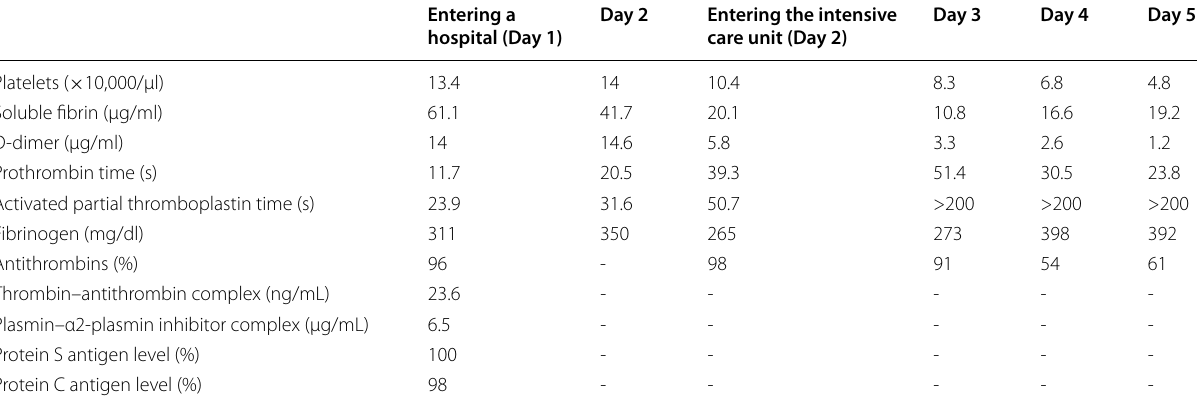
Table 1 Changes in markers of coagulation and fibrinolysis